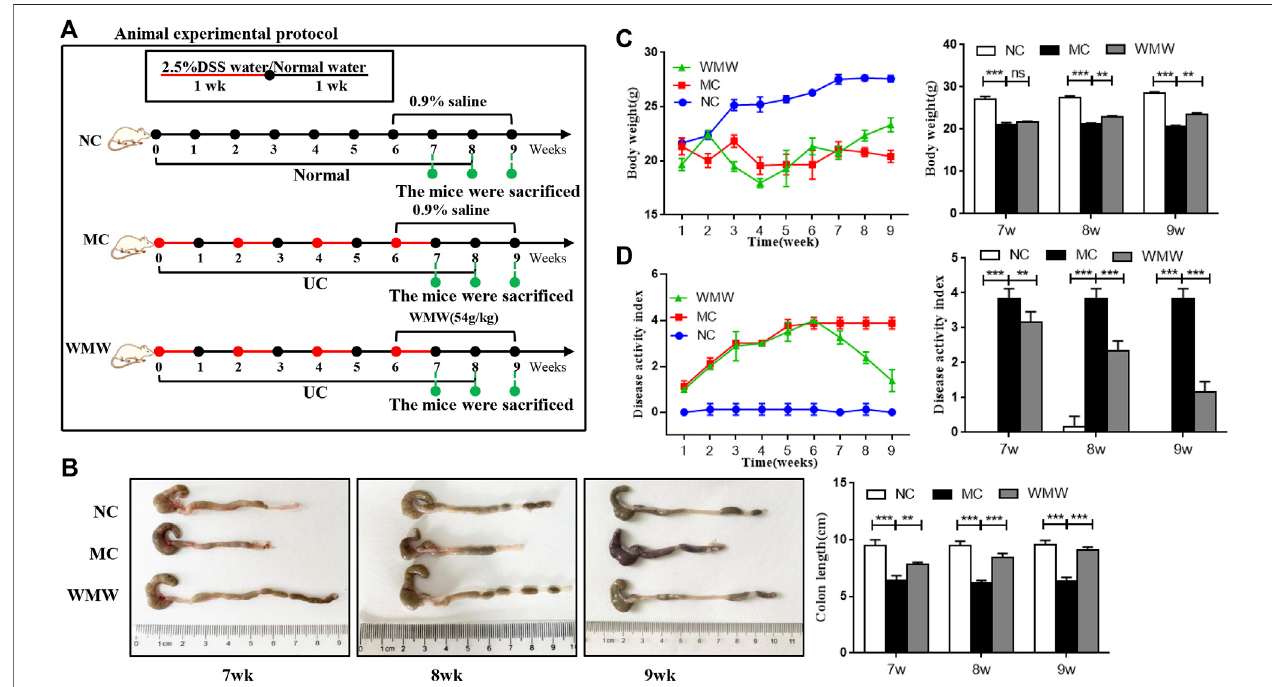
FIGURE3| Effect ofWMWon DSS-induced chroniccolitisinmice. (A) Schemeofexperimentalprocedurefor C57BL/6 miceweregivendrinking watercontaining 2.5% DSS for 1 week followed by normal drinking water for 2 weeks, This step was repeated four times for 8 weeks Mice were oral administrated with WMW (54 g/kg) for3 weeks,startingat7 weekspostDSSchallenge (B) Representativecolonimagesandthelengthofdifferentgroups. (C) DAIofmicewasrecordedweeklyduringthe experiment. (D) Body weight of mice was recorded daily during the experiment. n = 6 – 8, means ± SEM. * p < 0.05, ** p < 0.01, *** p < 0.001.